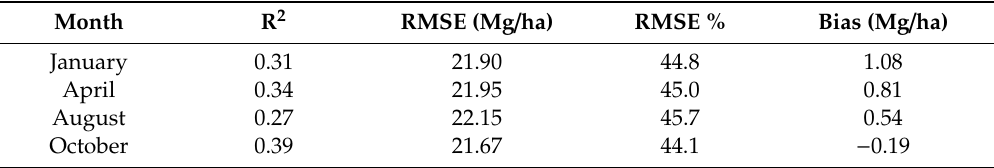
Table 5. Summary of the accuracy assessment results for the seasonal models based on the total vegetation. Month R 2 RMSE (Mg / ha) RMSE % Bias (Mg / ha)